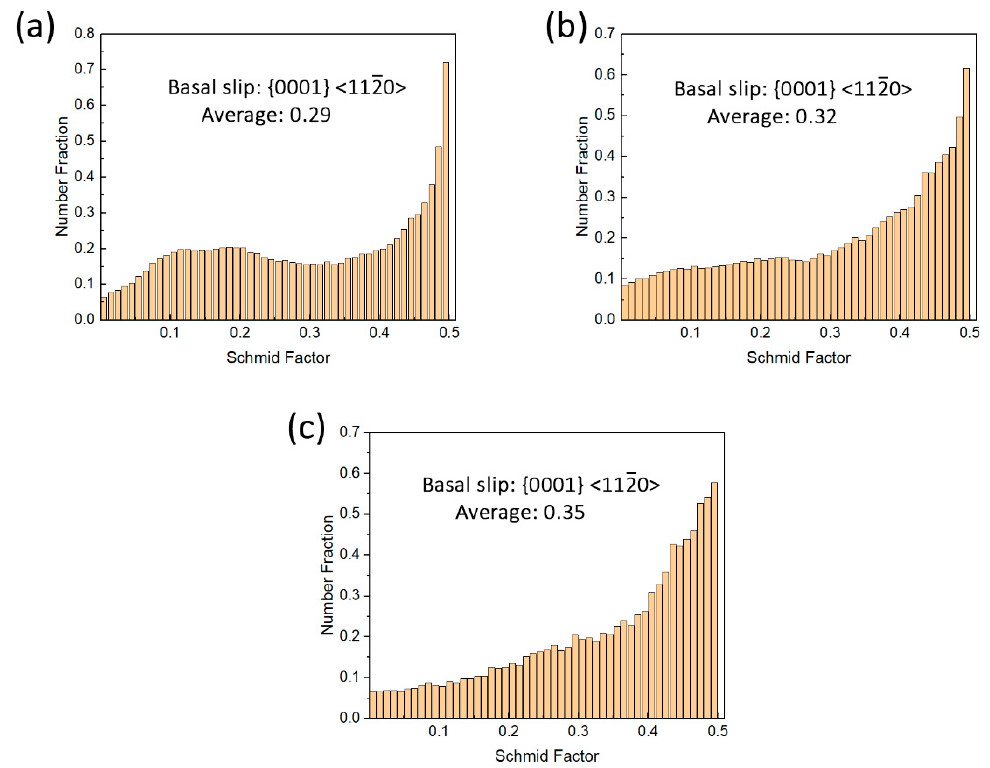
Figure 16. Schmid factor of the {0001} <1120> basal slip distribution histograms of the ZX10 alloy extruded at: ( a ) 300 °C, ( b ) 350 °C, and ( c ) 400 °C.